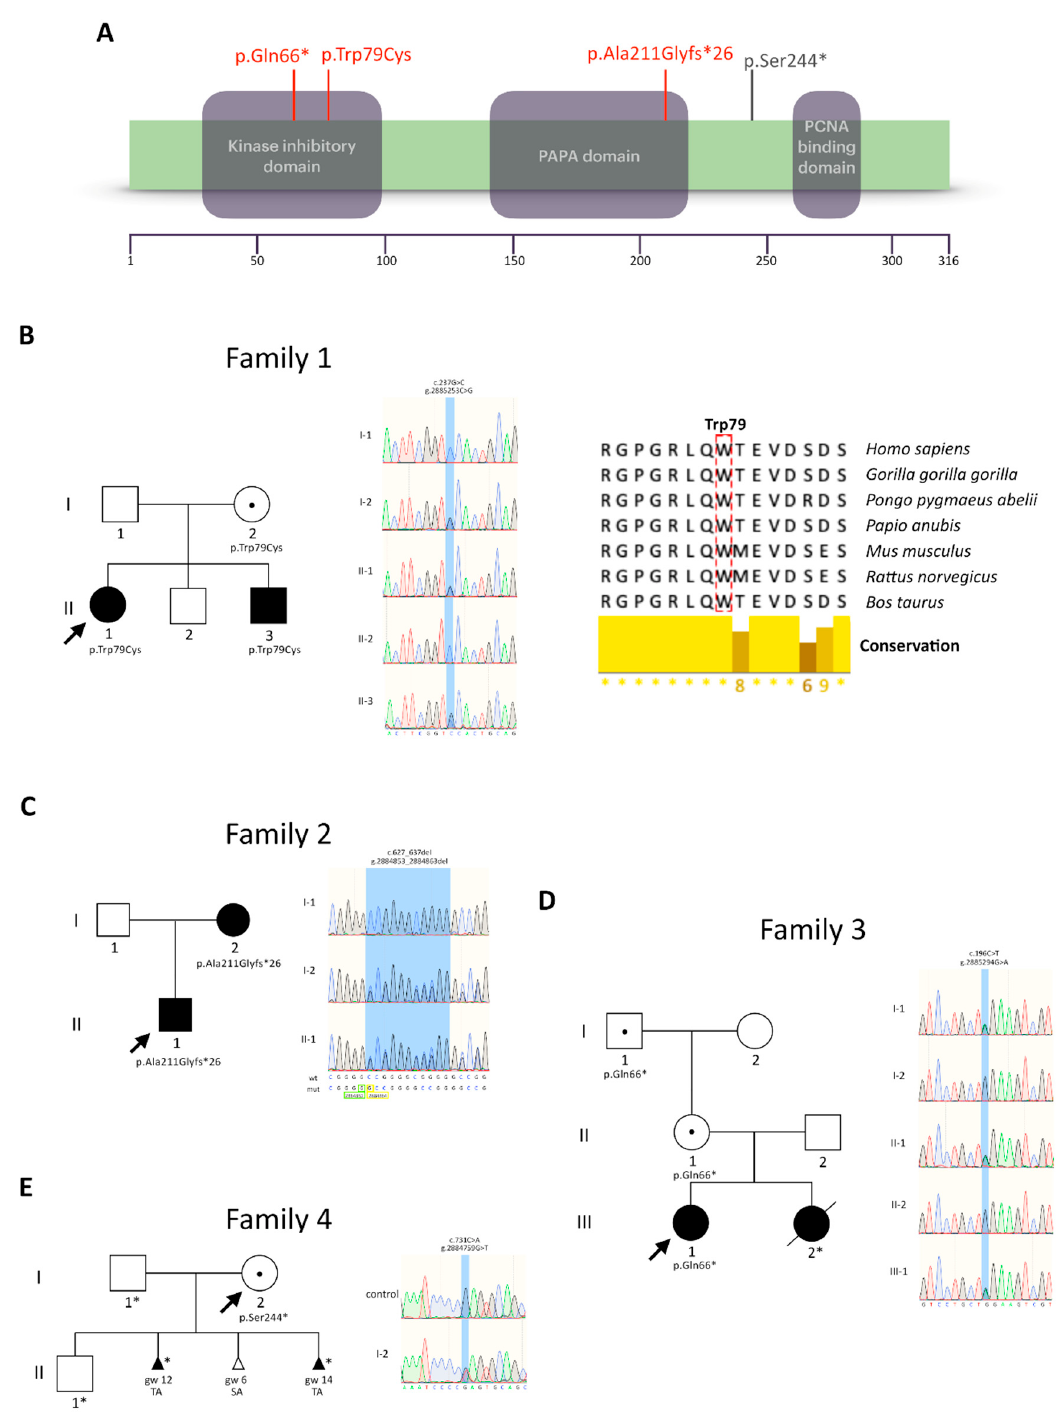
Figure 1. CDKN1C pathogenic variants in the four families under study. ( A ) Domain structure of the human CDKN1C (isoform A, NP_000067.1) depicting the position of the identified variants (novel variants in red; known variant in gray). ( B ) On the left, pedigree and DNA sequences showing the segregation of the variant in family 1. The patients or fetuses with BWS features are represented with black-filled symbols; the unaffected carriers of CDKN1C mutations with a dot in the middle of the symbol. The sequence variants are highlighted by a blue-shaded stripe in the electropherograms and their cDNA (NM_000076.2) and genomic (chr11, GRCh38/hg38) positions are indicated. On the right, evolutionary conservation of the tryptophan 79 (dashed in red) in primates and other mammals (Jalview software, V.2.11.1.3). ( C – E ) Pedigrees and DNA sequences showing the segregation of the variants in families 2–4. Asterisks indicate individuals unavailable